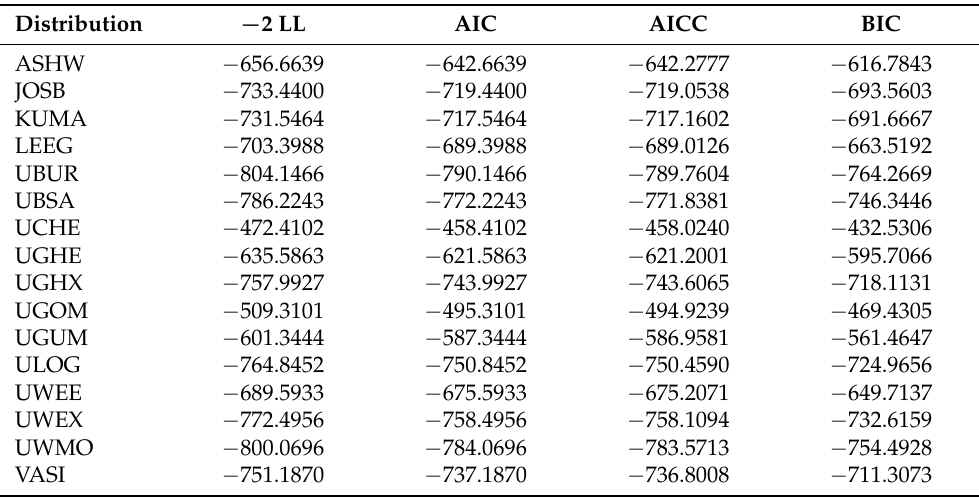
Table 16. Values of the indicated likelihood-based statistic and distribution for τ = 0.50 with data related to fat percentage at the